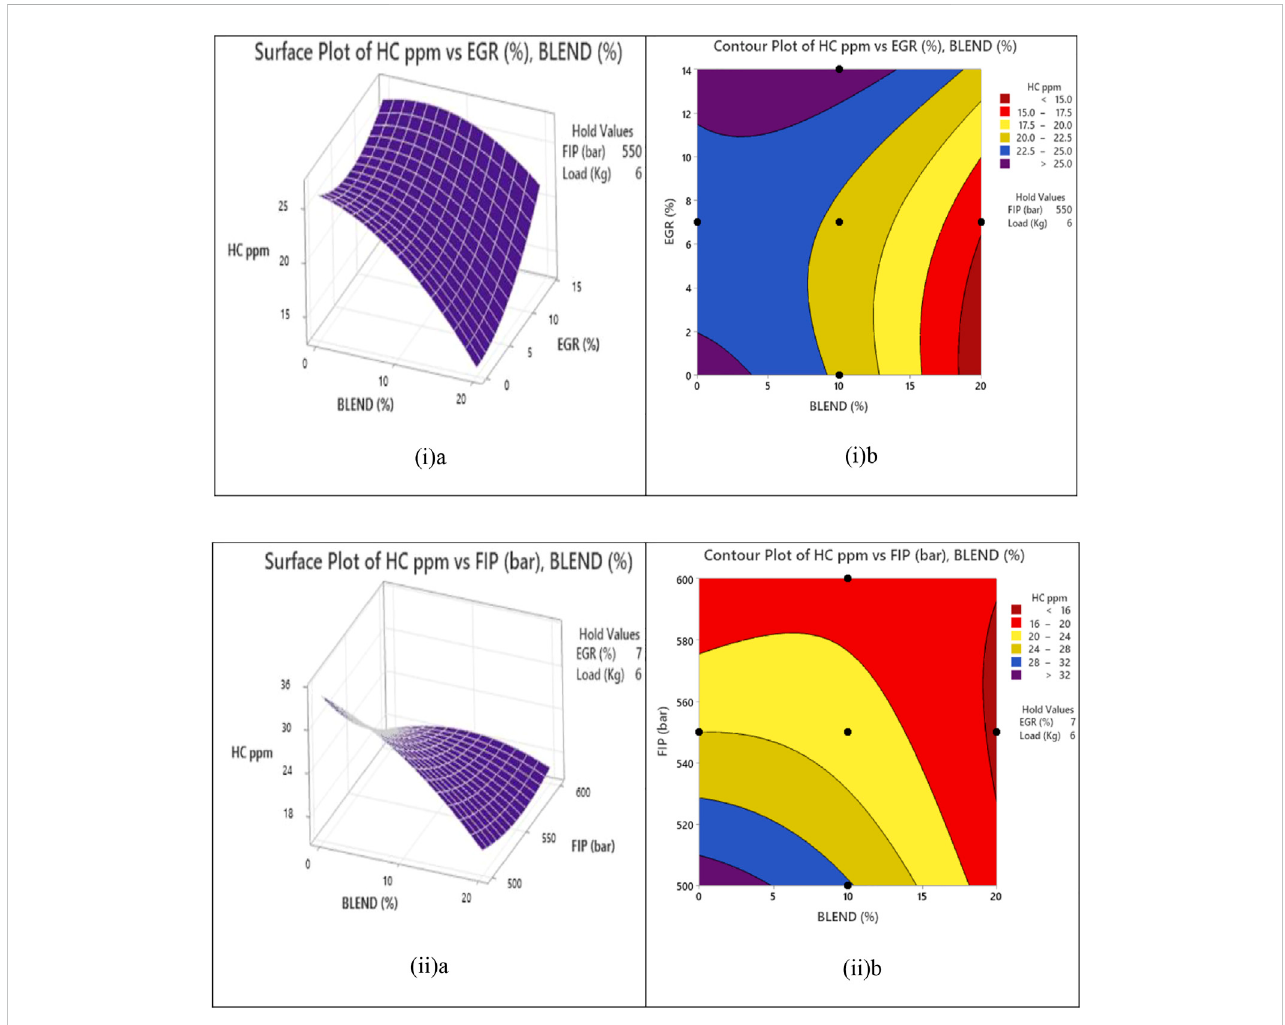
FIGURE 8 Effect of input factors on HC